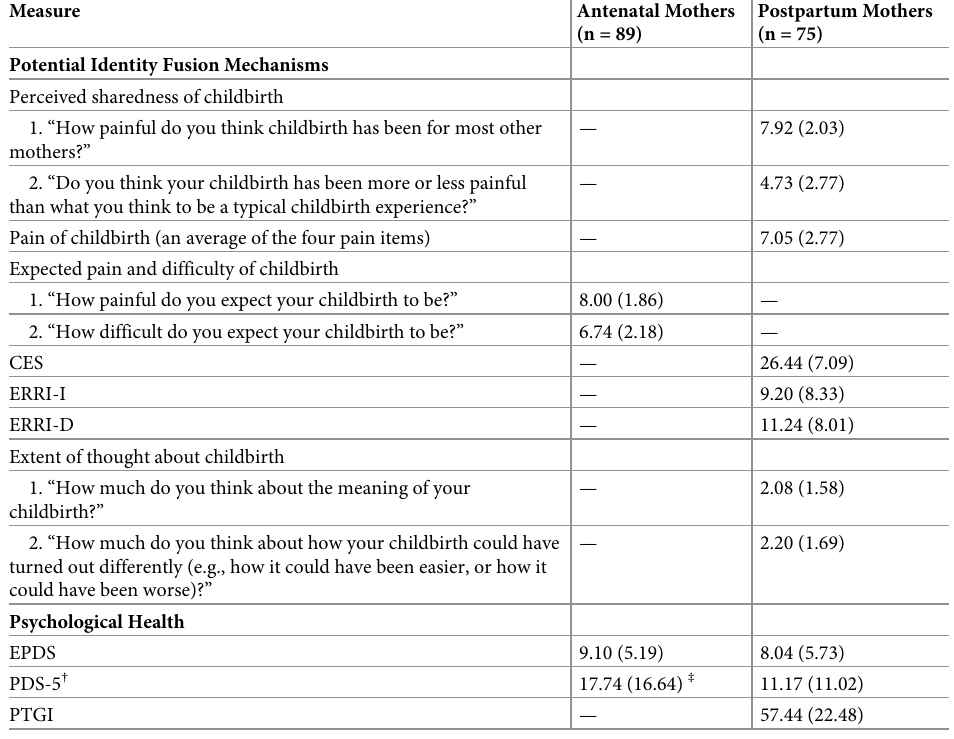
Table 1. Means (and SDs) for potential identity fusion mechanisms and psychological health as a function of mother